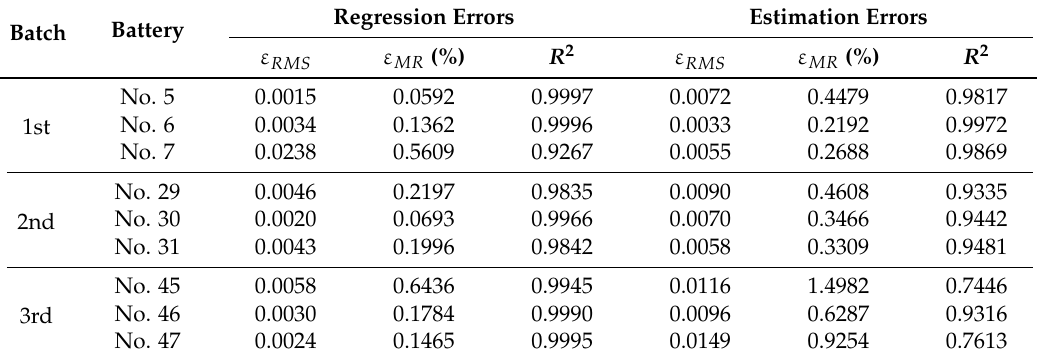
Table 5. Regression and estimation errors during the offline training and verification process.